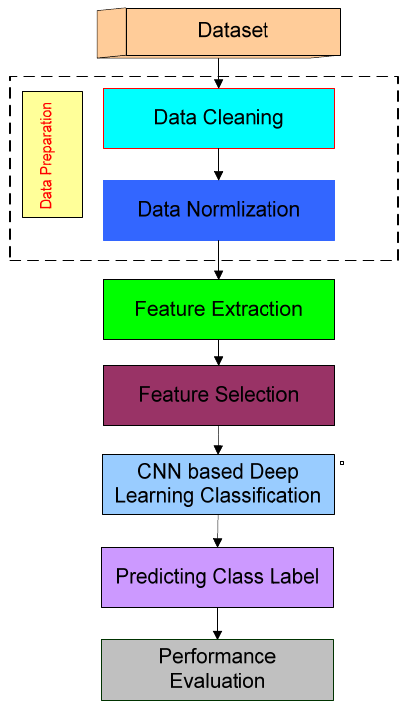
Figure 1. The flow of the planned system .